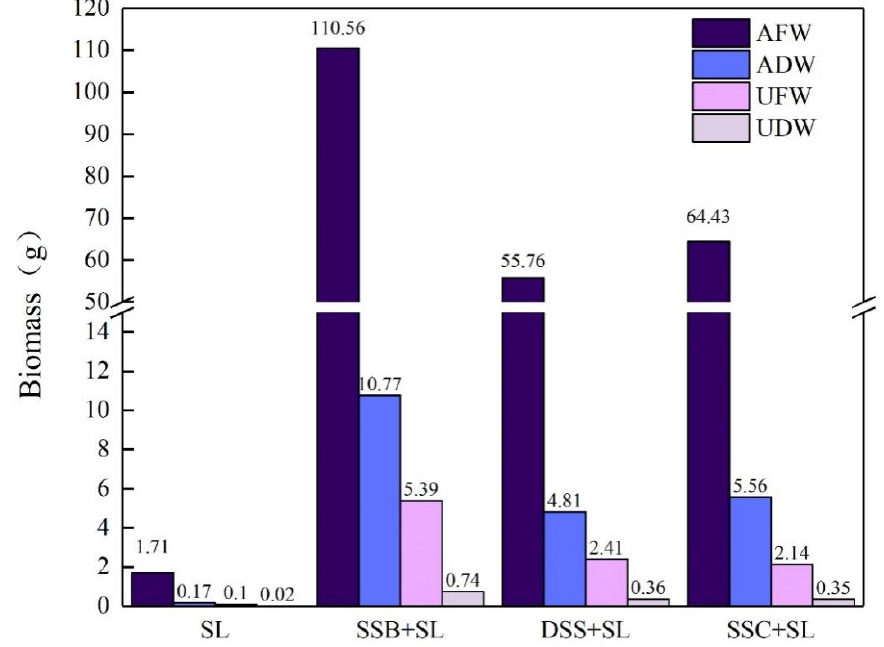
Figure 5. Dry and fresh weights of aboveground and underground parts of Chinese cabbage grown with four different soil samples. AFW: aboveground fresh weight; ADW: aboveground dry weight; UFW: underground fresh weight; UDW: underground dry weight.